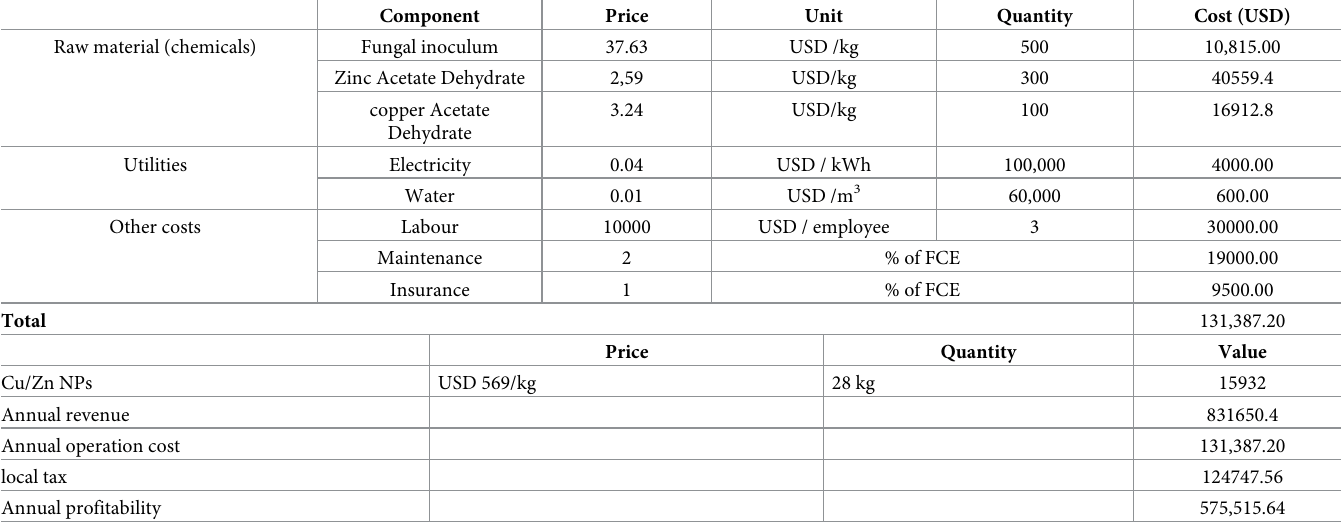
Table 5. Annual operation cost and profitability for biosynthesis of Cu/Zn NPs and application in inactivating pathogenic bacteria in